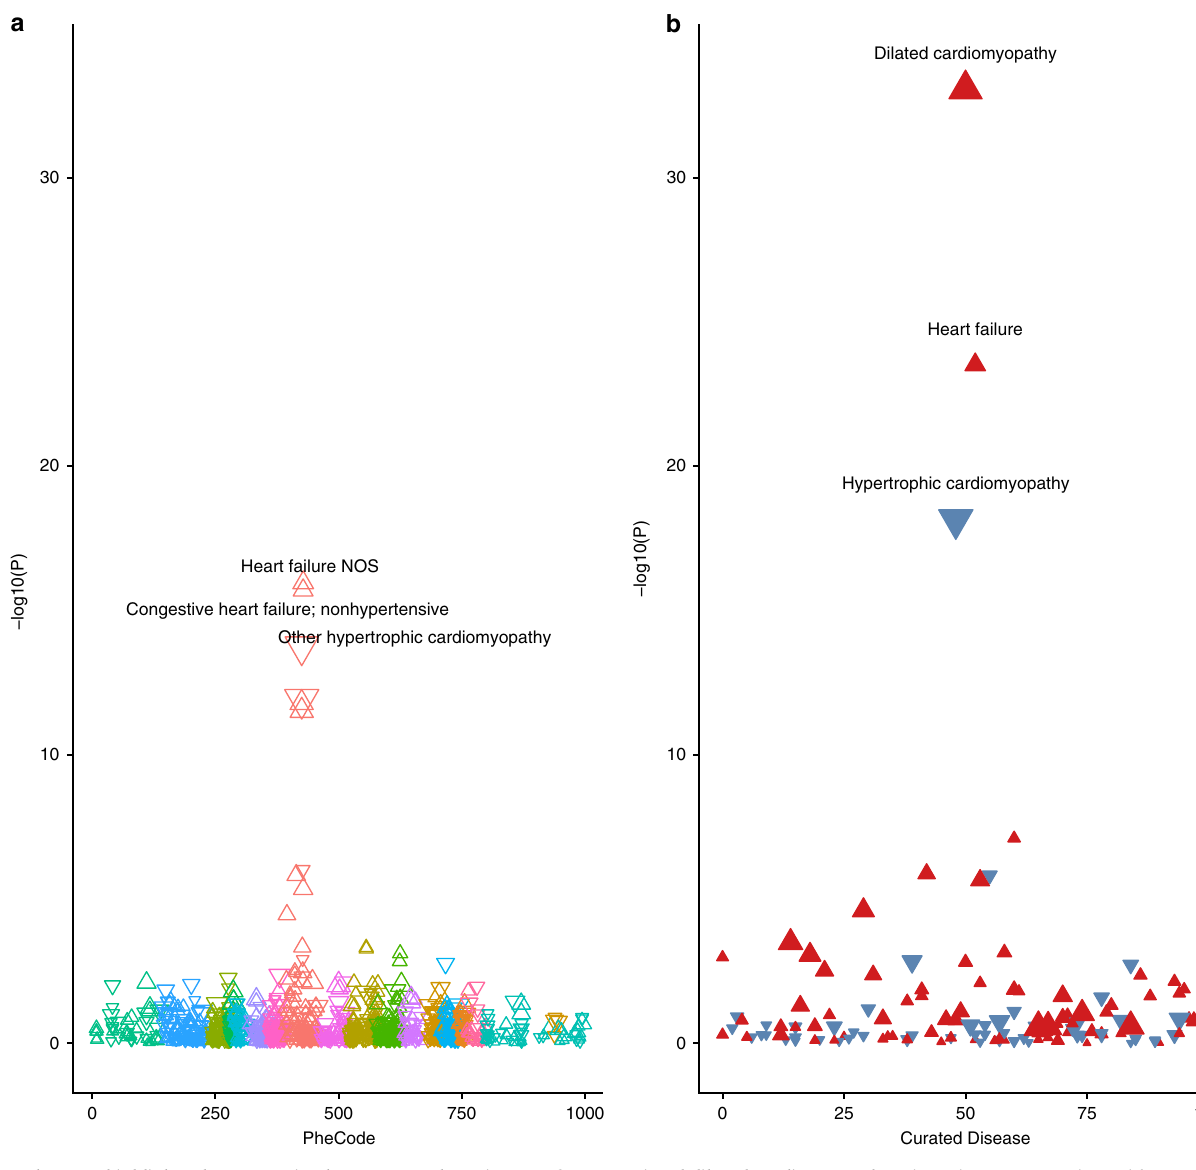
In fl uence of polygenic score in TTN truncation carriers .